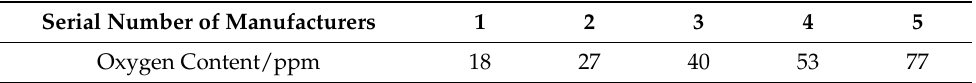
Table 1. Oxygen contents of Au-20Sn solders from different